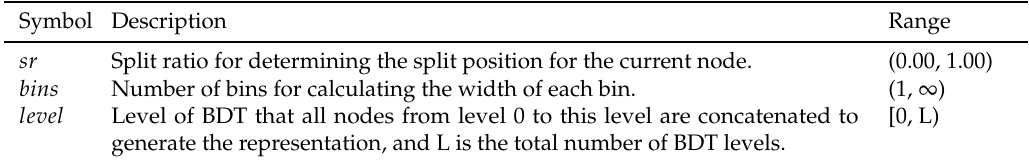
Table 1. Parameters of Binary Distribution Tree (BDT)-based representation.